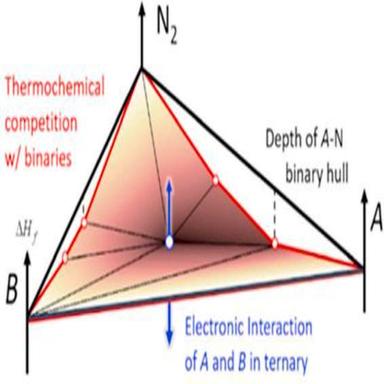
Ternary composition diagram of the A–B–N system representing the stability or metastability of a ternary metal nitride compound (blue circle) according to reference The vertical axis is the enthalpy of formation. The ternary compound competes energetically with that of the binaries (red lines) and the lattice energy of the ternary (blue arrow). The ternary nitride is thermodynamically stable if its enthalpy of formation is lower than other ternary compositions, and lower than that of the binaries and cons